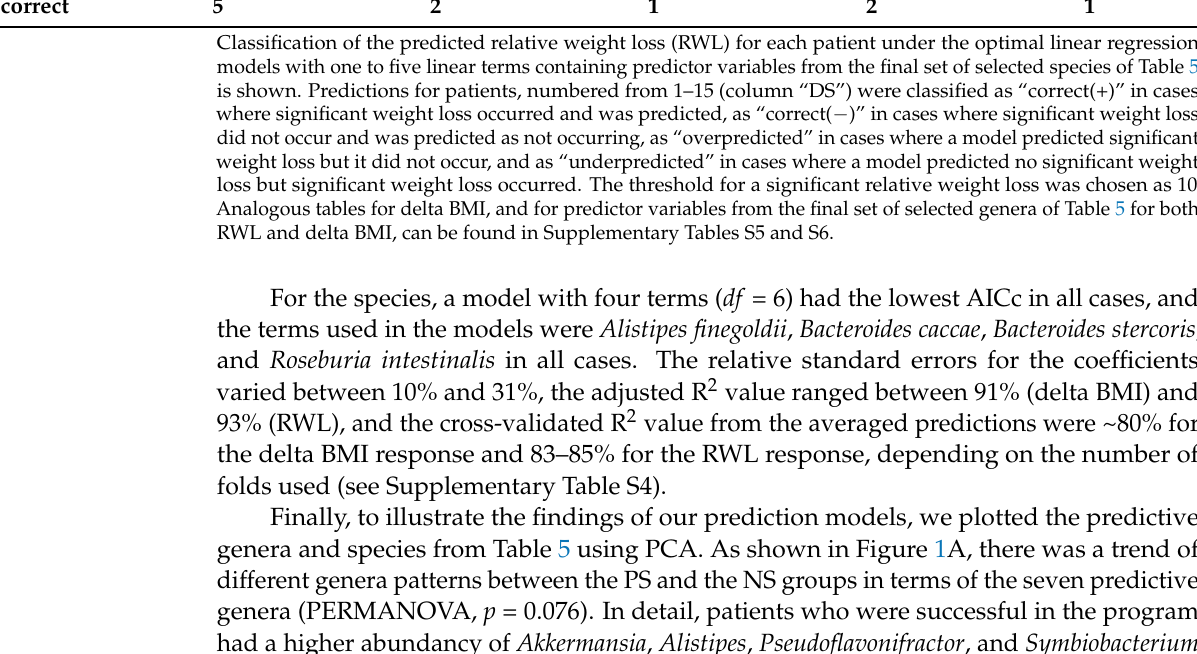
Classification of the predicted relative weight loss (RWL) for each patient under the optimal linear regression models with one to five linear terms containing predictor variables from the final set of selected species of Table 5 is shown. Predictions for patients, numbered from 1–15 (column “DS”) were classified as “correct(+)” in cases where significant weight loss occurred and was predicted, as “correct( − )” in cases where significant weight loss did not occur and was predicted as not occurring, as “overpredicted” in cases where a model predicted significant weight loss but it did not occur, and as “underpredicted” in cases where a model predicted no significant